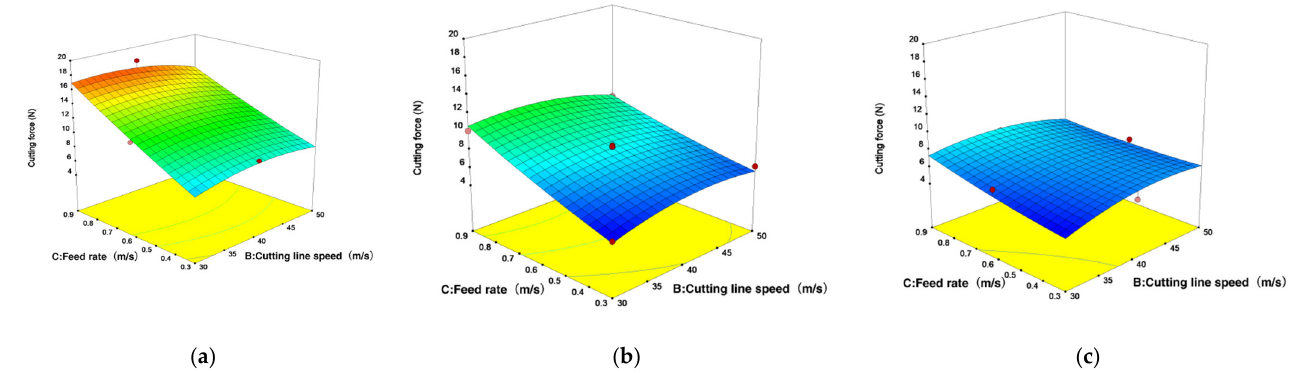
Figure 7. Response surface of cutting force to the interaction of various test factors, ( a ) diameter 25 mm ( b ) diameter 20 mm ( c ) diameter 15 mm.